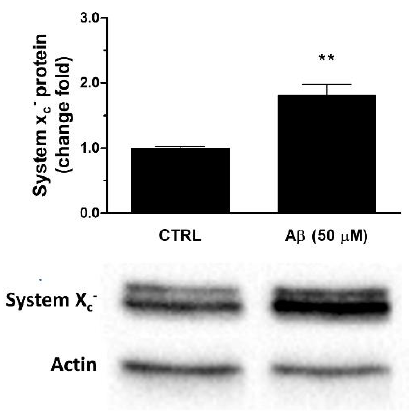
Figure 4. Effects of A β 25-35 on System X c − protein expression in U373 cells. Cells were treated with A β 25-35 (50 µ M) for 24 h. The graph shows the densitometric analysis of the western blots for each sample. Data are computed relative to the internal housekeeping gene (actin) and are the means ± SEM from three separate experiments, each carried out in duplicate. One-way ANOVA, followed by Bonferroni’s test, was used to define significant differences. ** p ≤ 0.01 vs. CTRL.